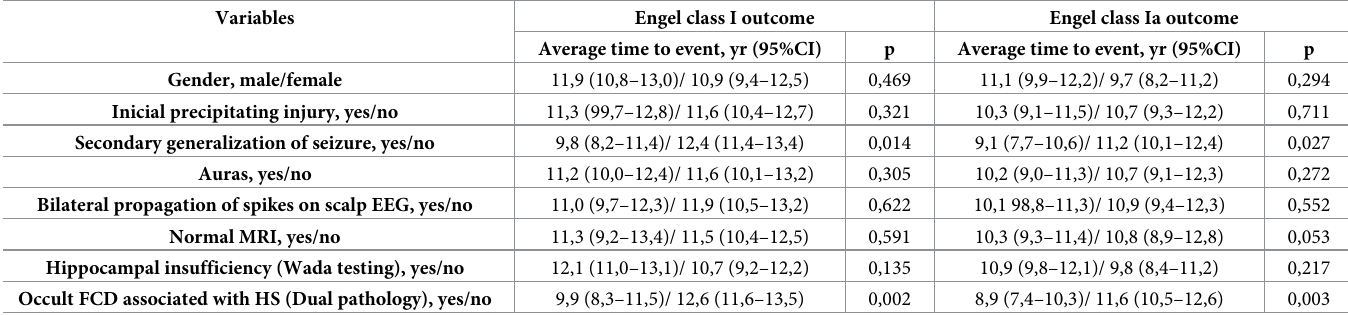
Table 3. Univariate analysis of predictors of seizure outcome (log-rank